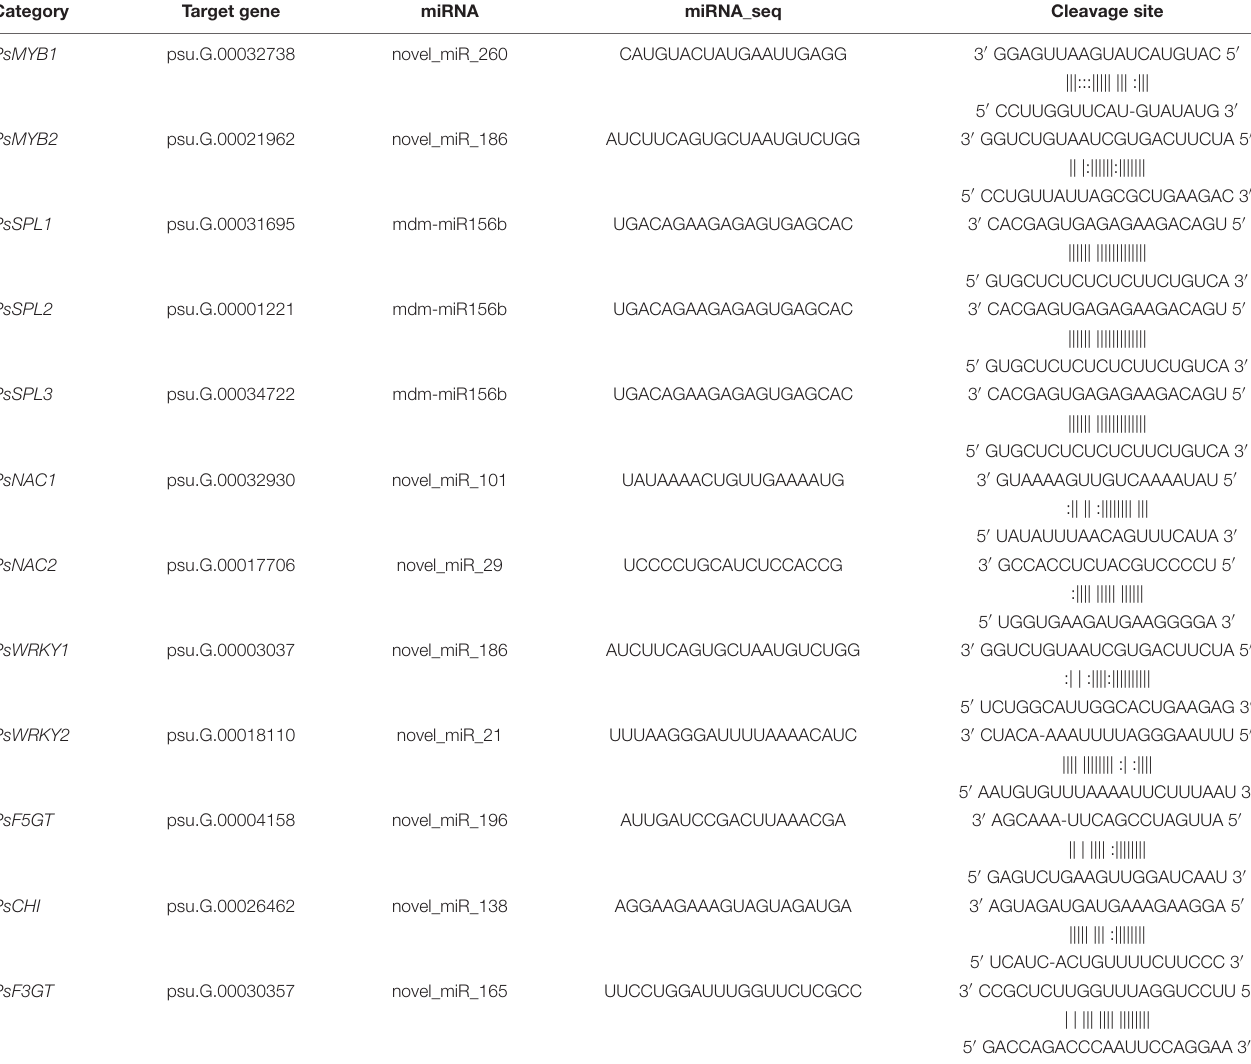
TABLE 1 | The candidate DEM-target gene pairs involved in yellow pigmentation of tree peony.